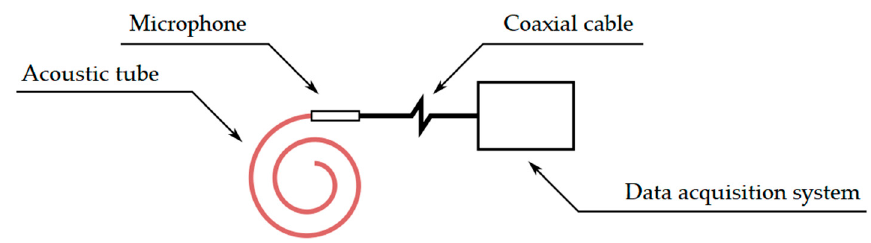
Figure 5. Diagram of the acoustic sensor.